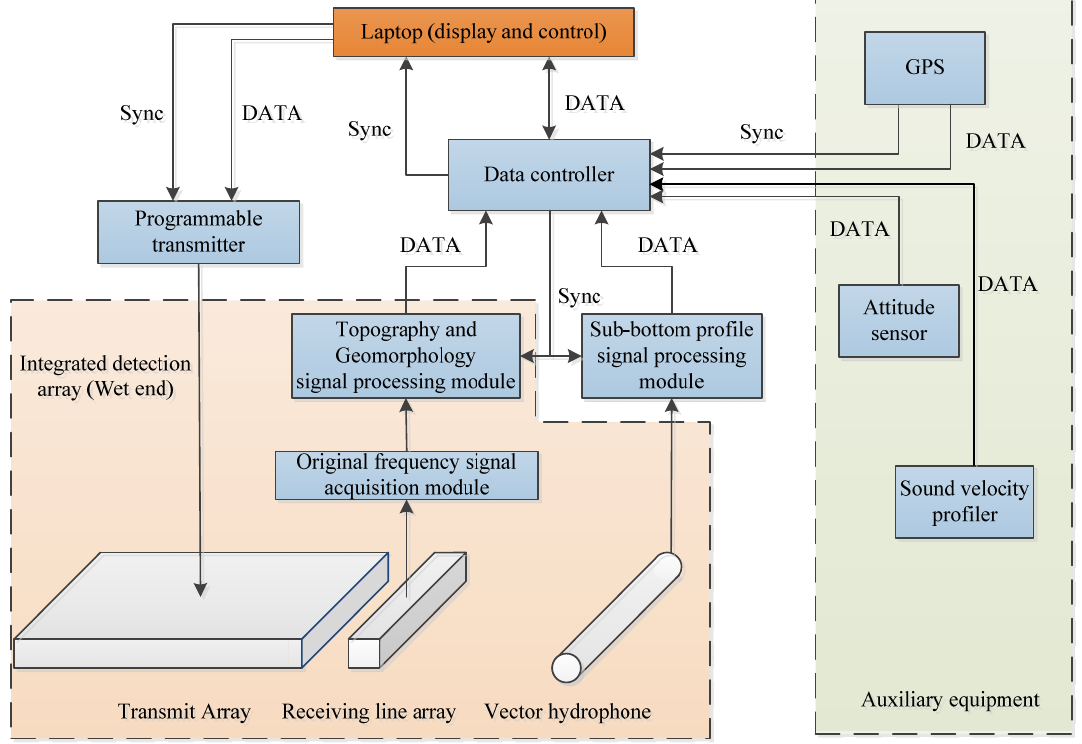
Figure 2. The architecture of portable seabed feature integrated detection sonar (PSIDS).